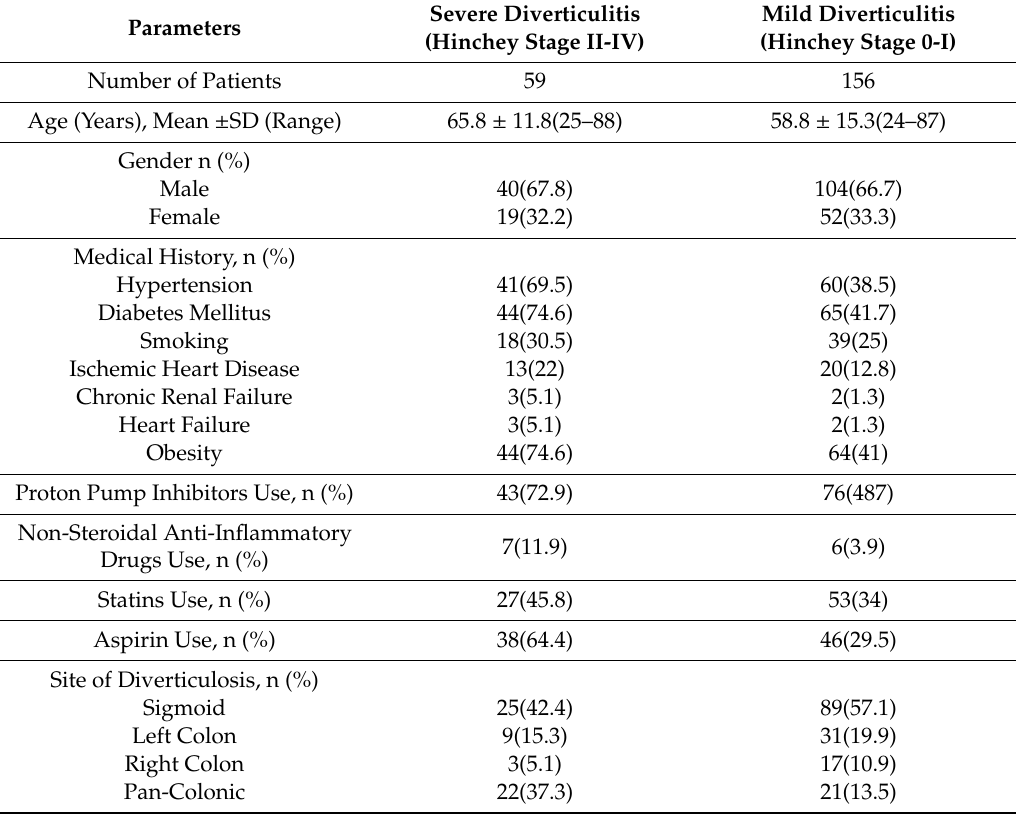
Table 4. Demographics and baseline characteristics of the study cohort with